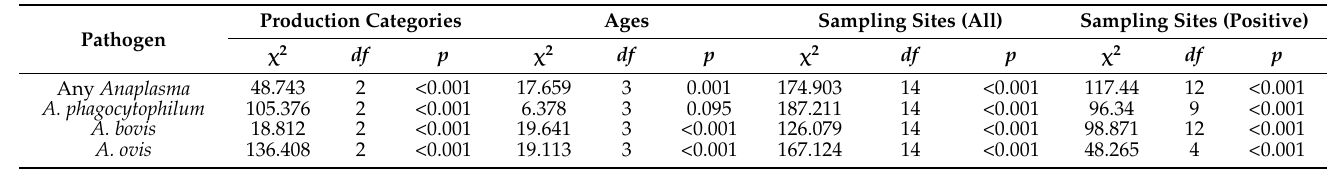
Table 5. Differences in the occurrence of Anaplasma in goats among production categories, ages, and sampling sites, as indicated by results of chi-square analysis.